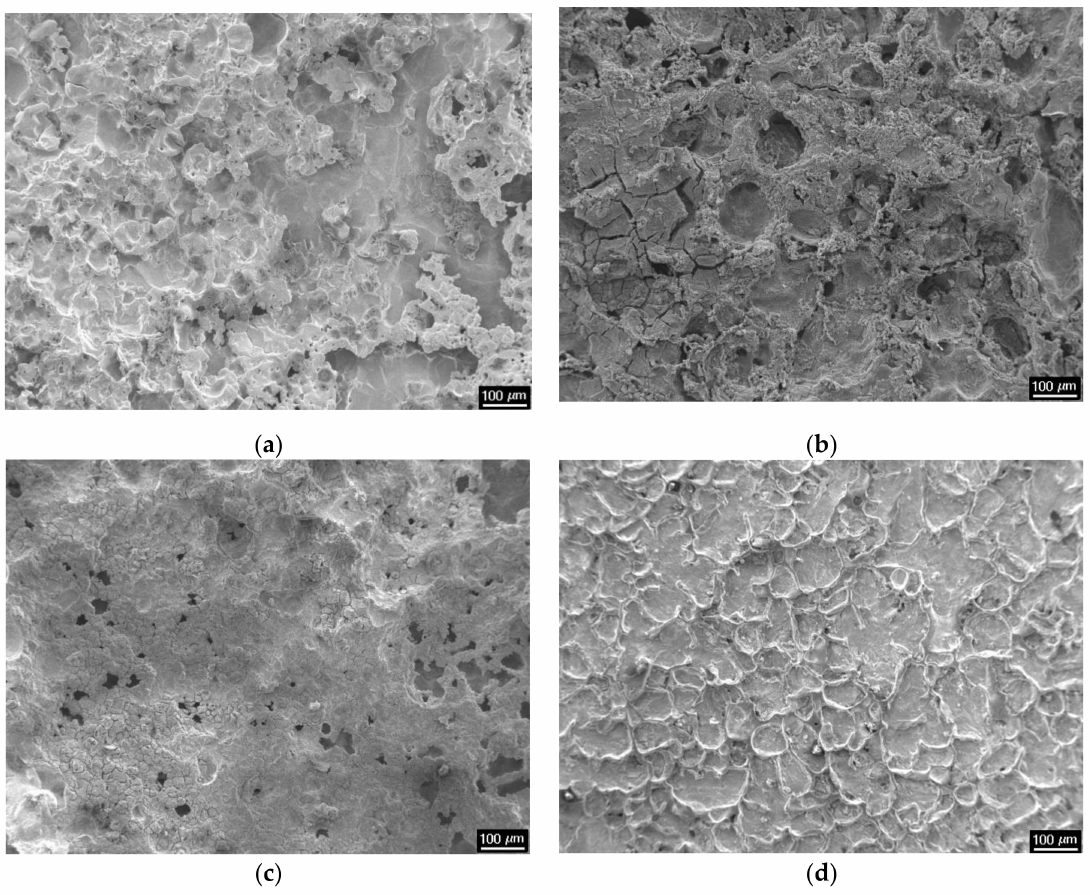
Figure 7. SEM ( a ) for steel 1, ( b ) for steel 2, ( c ) for steel 3, and ( d ) for steel 4 micrographs on steel surface after